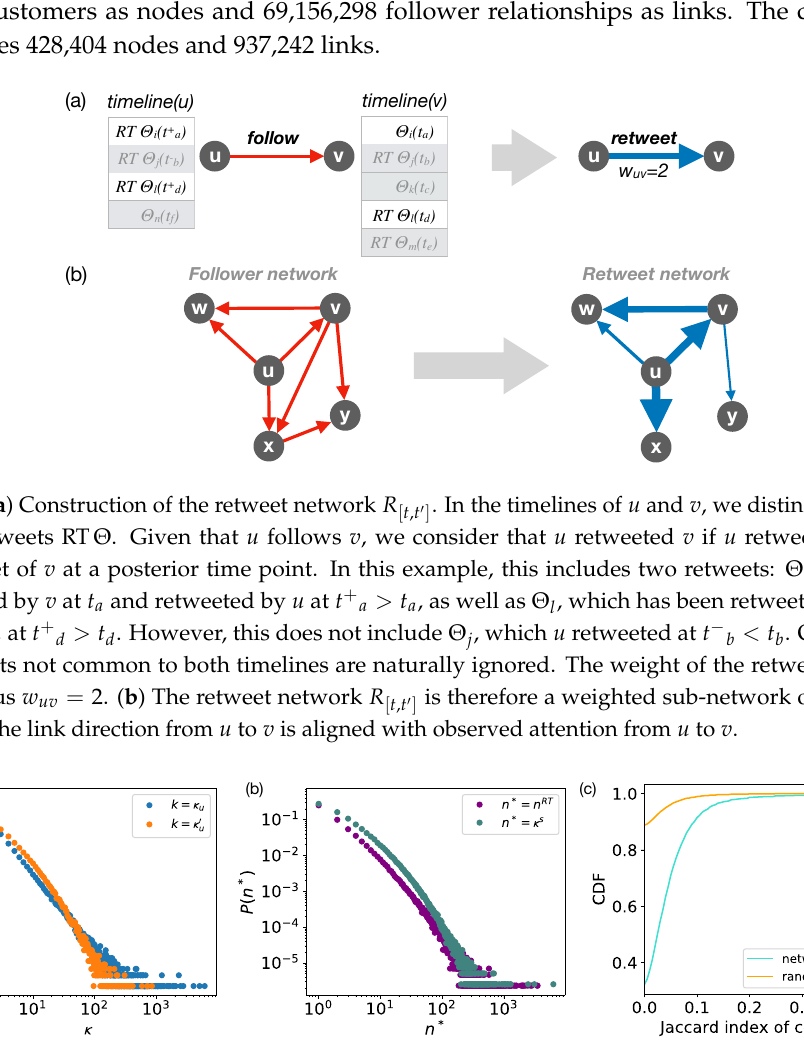
Figure 2. Distributions of degrees, activity, and similarity measures. ( a ) Distributions of the κ u out- and κ (cid:48) u in-degrees of nodes in the retweet network. ( b ) Distributions of the number of retweets ( n RT ) and number of hashtags ( κ s ) per user. ( c ) Cumulative distribution of the Jaccard similarity between hashtag sets of connected (blue) and randomly selected (orange) pairs of users of the retweet